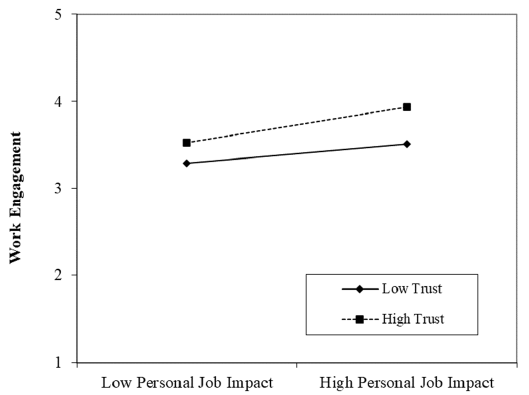
Figure 2. Relationship between individual job impact and work engagement moderated by trust. We also conducted a linear-moderated regression to test hypothesis 6 (i.e., “Trust weakens the positive association between (a) workload and (b) individual job impact and emotional exhaustion”). Trust did not have a significant moderating effect on workload ( β = 0.04, p = 0.443) or individual job impact ( β = − 0.08, p = 0.139; Table 2) in relation to emotional exhaustion. Hence, H6a and H6b were not supported. Hypothesis 7 (i.e., “Autonomy strengthens the relationship between (a) workload and (b) individual job impact and work engagement”) was tested using a moderated regression analysis. As shown in Figure 3, a positive moderating effect on the relationship between individual job impact and work engagement was found ( β = 0.13, p = 0.012). Simple-slope analyses showed a significant positive relationship between individual job impact and work engagement for high autonomy ( β = 0.20, p = 0.003), but no significance for low autonomy ( β = − 0.05, p = 0.421). These results support H7b, but not